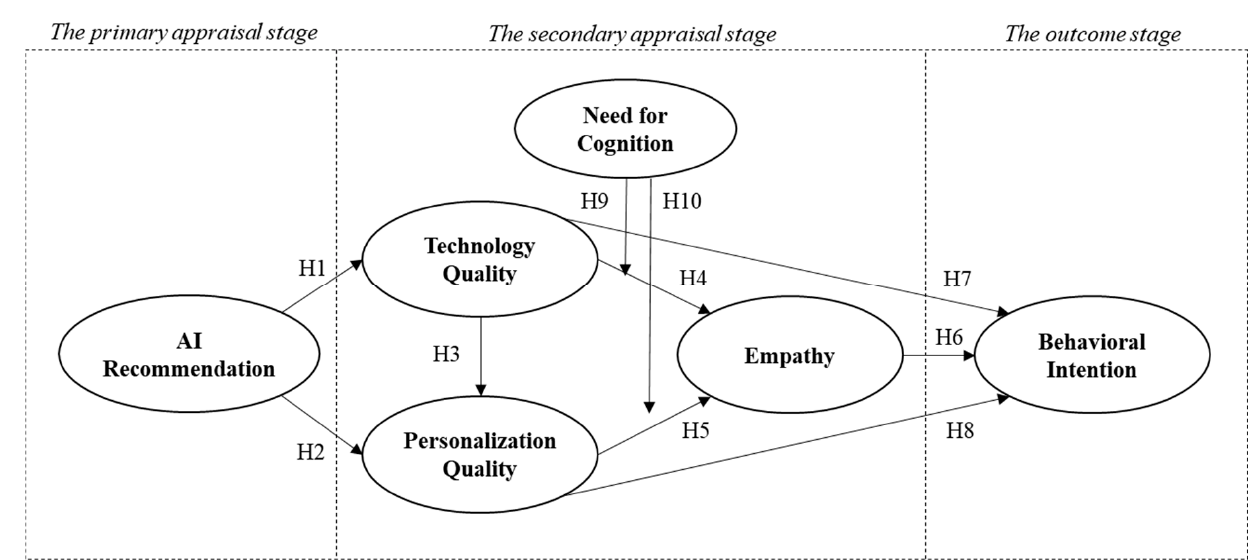
Figure 1. Research Model.